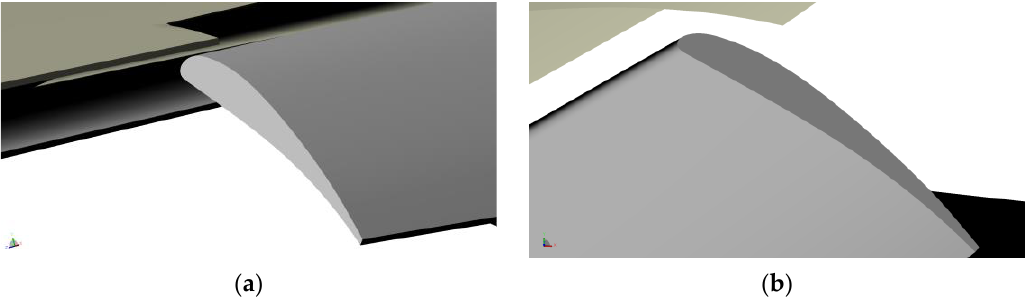
Figure 1. Geometry around the baseline flap side-edge. ( a ) Side view; ( b ) bottom view.